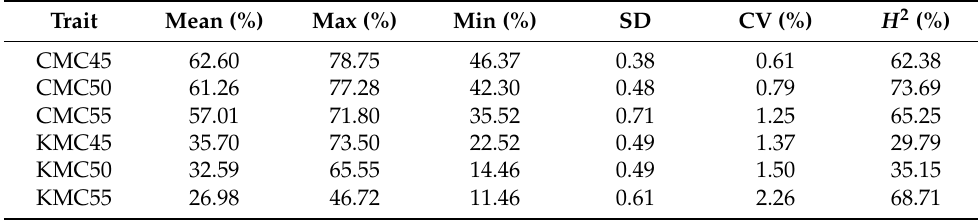
Table 1. Phenotypic variations of 12 traits in 241 maize inbred